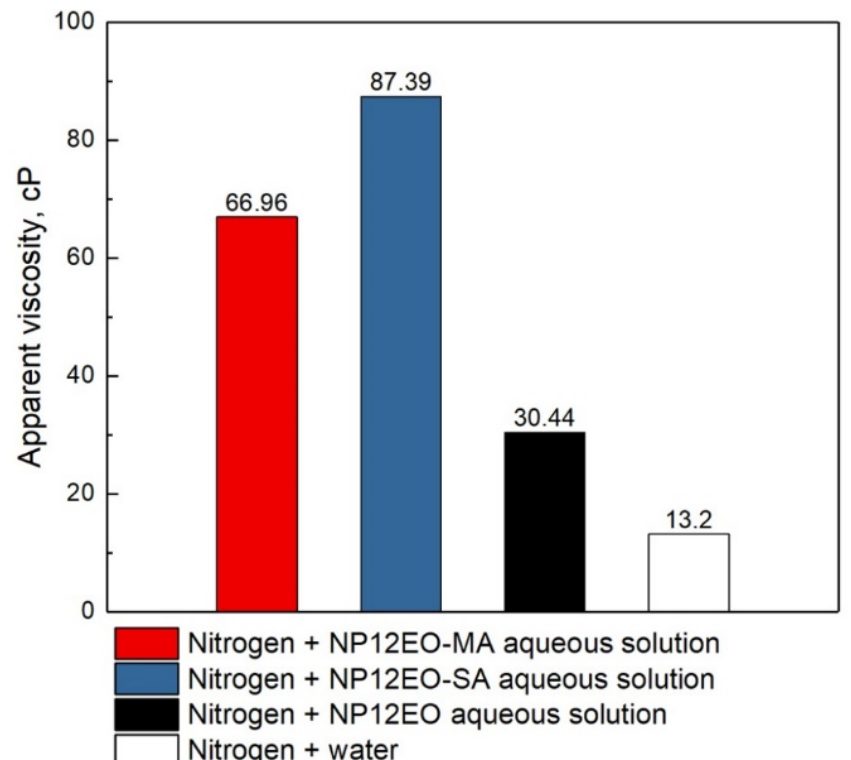
Figure 8. Comparison of apparent viscosities of gas/liquid systems in filtration experiments at f g = 0.5.